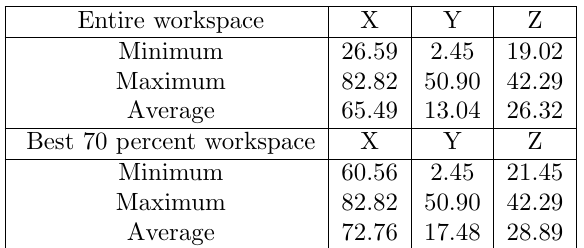
Table 1: Cartesian stiffness ( N/µm ) of the 3-DOF Gantry-Tau in the entire workspace and the best 70 % of the workspace.